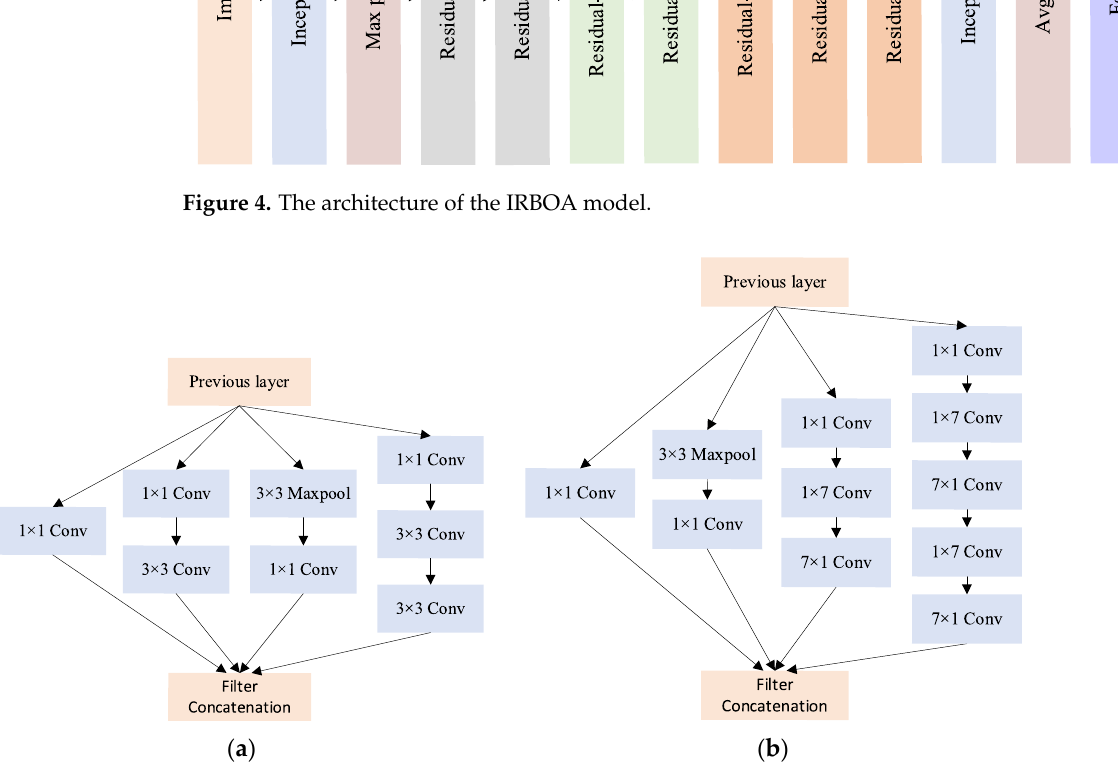
Figure 5. Inception-v3 structure. ( a ) Inception-A structure. ( b ) Inception-B structure.